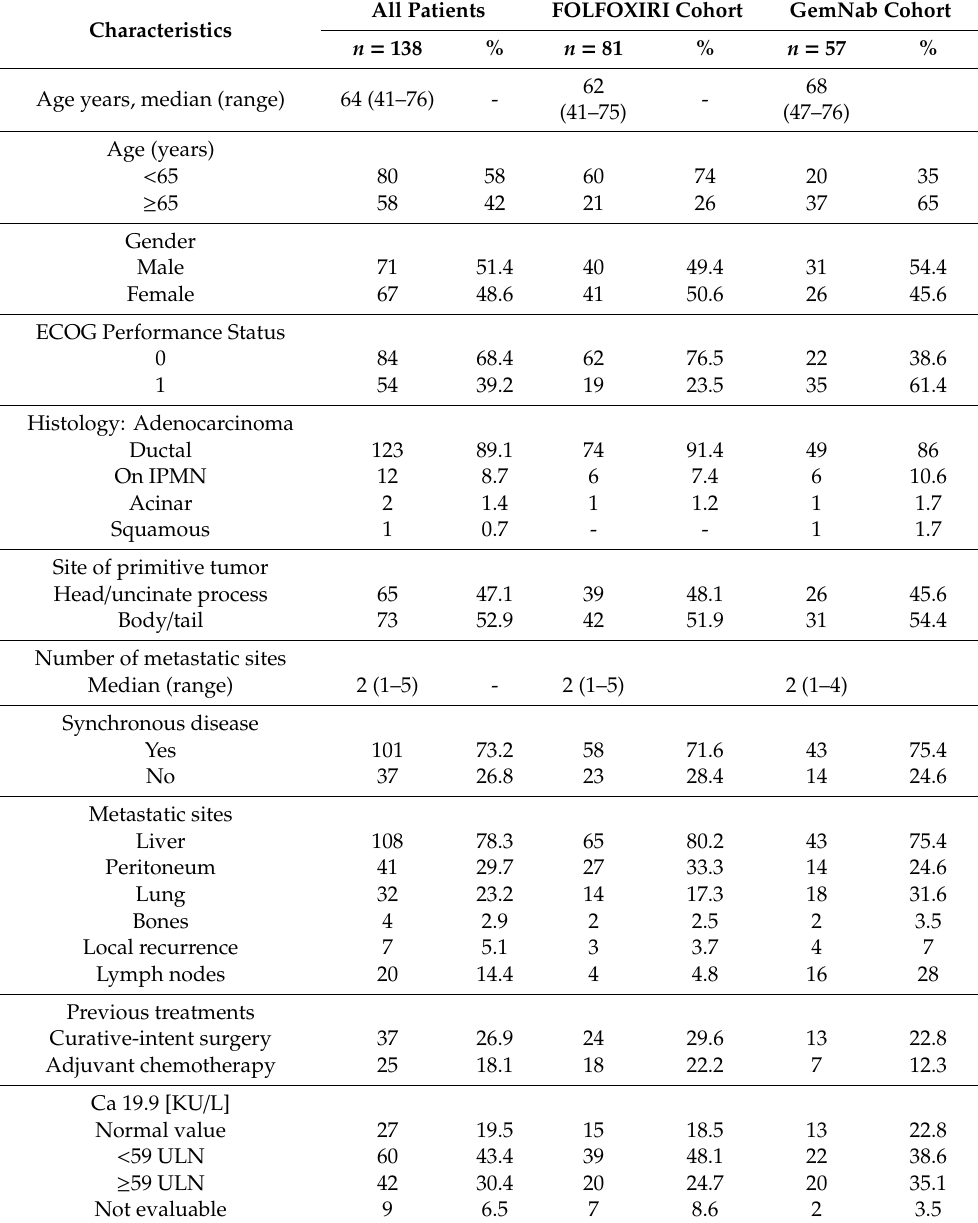
Table 1. Patients’ characteristics at